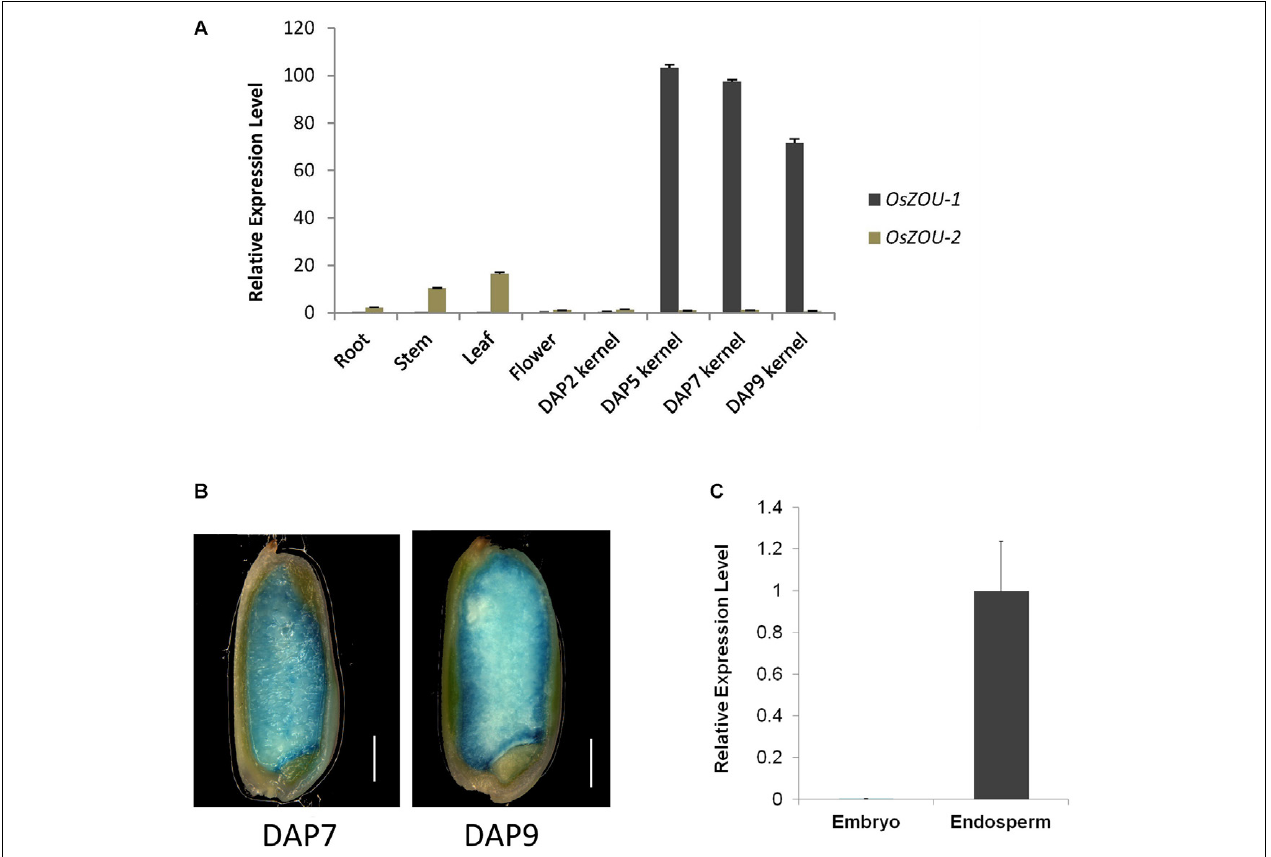
FIGURE 2 | OsZOU-1 and OsZOU-2 expression analyses. (A) Expression of OsZOUs in different tissues, including the root, stem, leaf, unopened flower, and seeds at different DAPs, as detected by qPCR analysis. The expression level of OsZOU-2 in unopened flowers was set as 1, and all experiments were repeated three times. (B) GUS staining of pOsZOU-1::GUS transgenic line seeds at seven DAP and nine DAP. Scale bars = 1 mm. (C) qPCR analysis of OsZOU-1 expression in dissected seed compartments. The embryo and endosperm were isolated separately from developing seeds at five DAP, and the expression level of OsZOU-1 in the endosperm was set as 1. Error bars in (A,C) denote SDs calculated from technical triplicates on pools of material from three plants, with AtEIF4 used as the reference